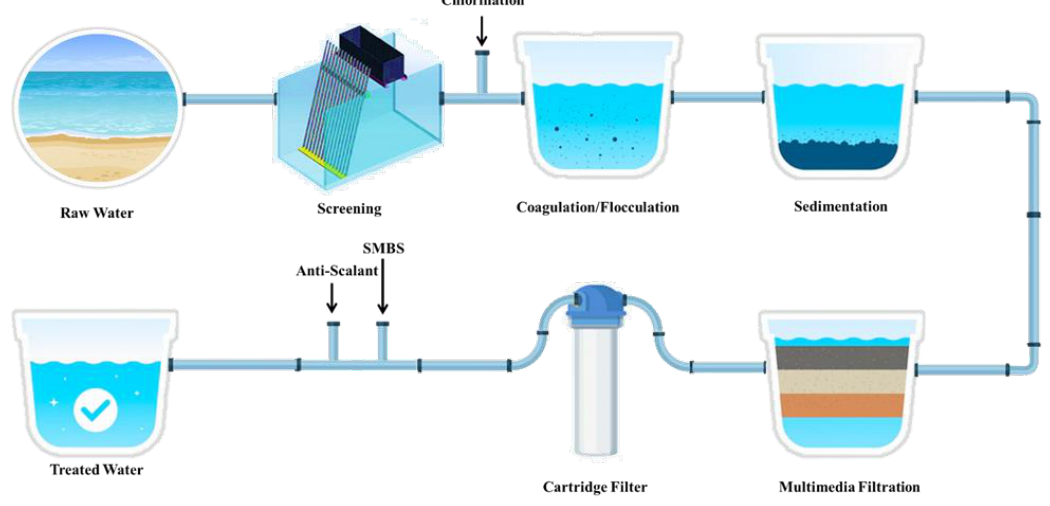
Figure 3. Simplified illustration of a conventional pretreatment system.